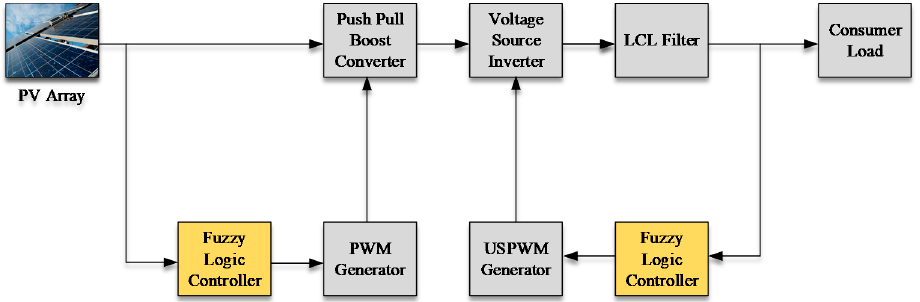
Figure 2. Block diagram of the proposed methodology. USPWM, unipolar sinusoidal pulse width modulation; PV, photovoltaic.